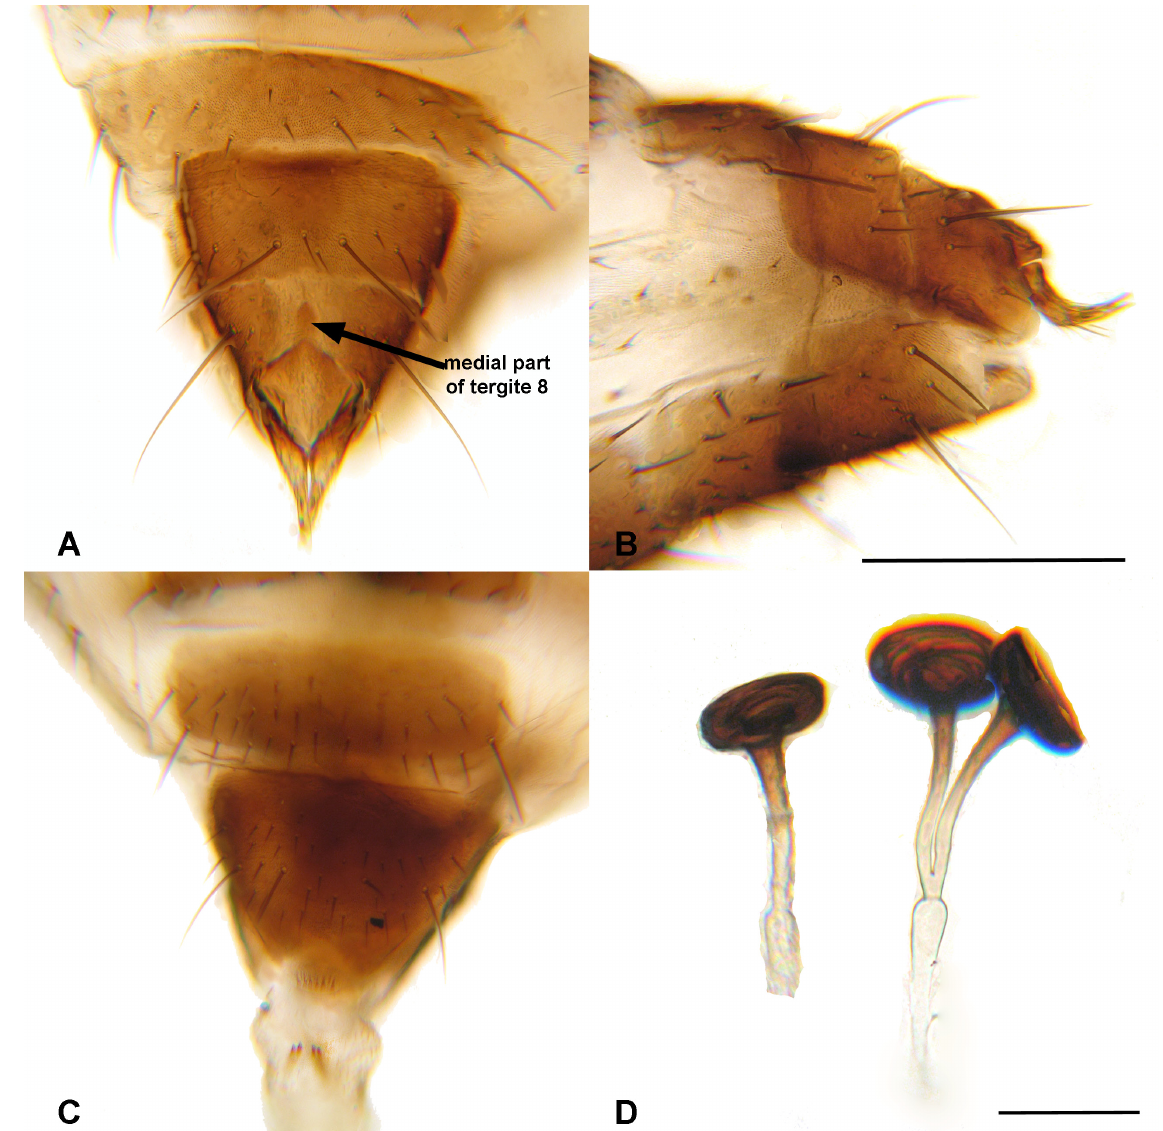
Fig. 12. Rudolfina howdeni sp. nov., female terminalia (debu1086100). A . Terminal abdominal segments, dorsal view. B . Same as preceding, lateral view. C . Same as preceding, ventral view. D . Spermathecae. Scale bars: A–C = 0.30 mm; D =